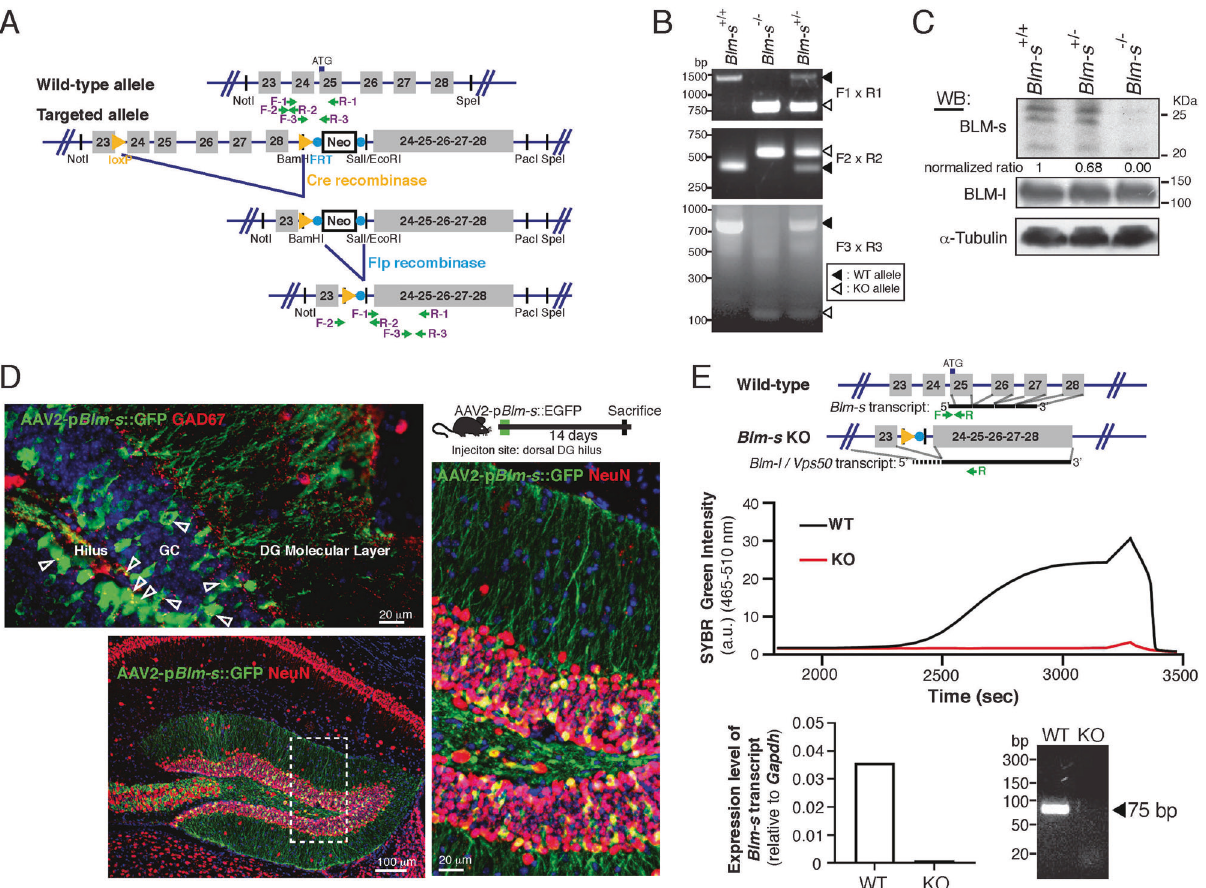
Fig. 1 Generation of Blm-s -knockout mice. A Schematic diagram of mouse Blm-l / Blm-s genomic structure, of which Blm-s gene is deleted by homologous recombination and replaced with a recombinant cDNA containing exons 24 – 28 to preserve the Blm-l gene expression in the targeted allele. B Genotyping results of wild-type (WT, Blm-s + / + ), heterozygotic ( Blm-s + / − ) and homozygotic Blm-s -knockout (KO, Blm-s − / − ) mice. The PCR primers used are indicated in A . C Immunoblot analysis of BLM-s and BLM-l in the whole brain lysates from 60-day-old adult Blm-s + / + , Blm-s + / − , and Blm-s − / − mice. α -tubulin is a loading control. D Schematic diagram and representative images of expression of AAV virus carrying EGFP driven by Blm-s- speci fi c promoter 14 days after injection into dorsal DG of 60-old-day male wild-type mice. Note that EGFP signals colocalize with GCs (NeuN + ), but not with interneurons (GAD67 + ). DG dentate gyrus, GC hippocampal DG granule cells. E Schematic diagram of a PCR primer set that speci fi cally recognizes Blm-s m RNA, but not Blm-l/Vps50 mRNA. The forward primer (F) is derived from the 5 ’ untranslated region of Blm-s transcript located in the 24th intron, which is spliced off in the Blm-l/Vps50 transcript. Middle panel shows quantitative SYBR Green-labeled RT-PCR result ampli fi ed by this speci fi c primer set of the hippocampal RNA derived from WT and KO mice, respectively. a.u. arbitrary unit. Lower panel reveals the expression level of Blm-s relative to the house-keeping gene Gapdh (left) and gel electrophoresis of the RT-PCR product from the hippocampi of each genotype